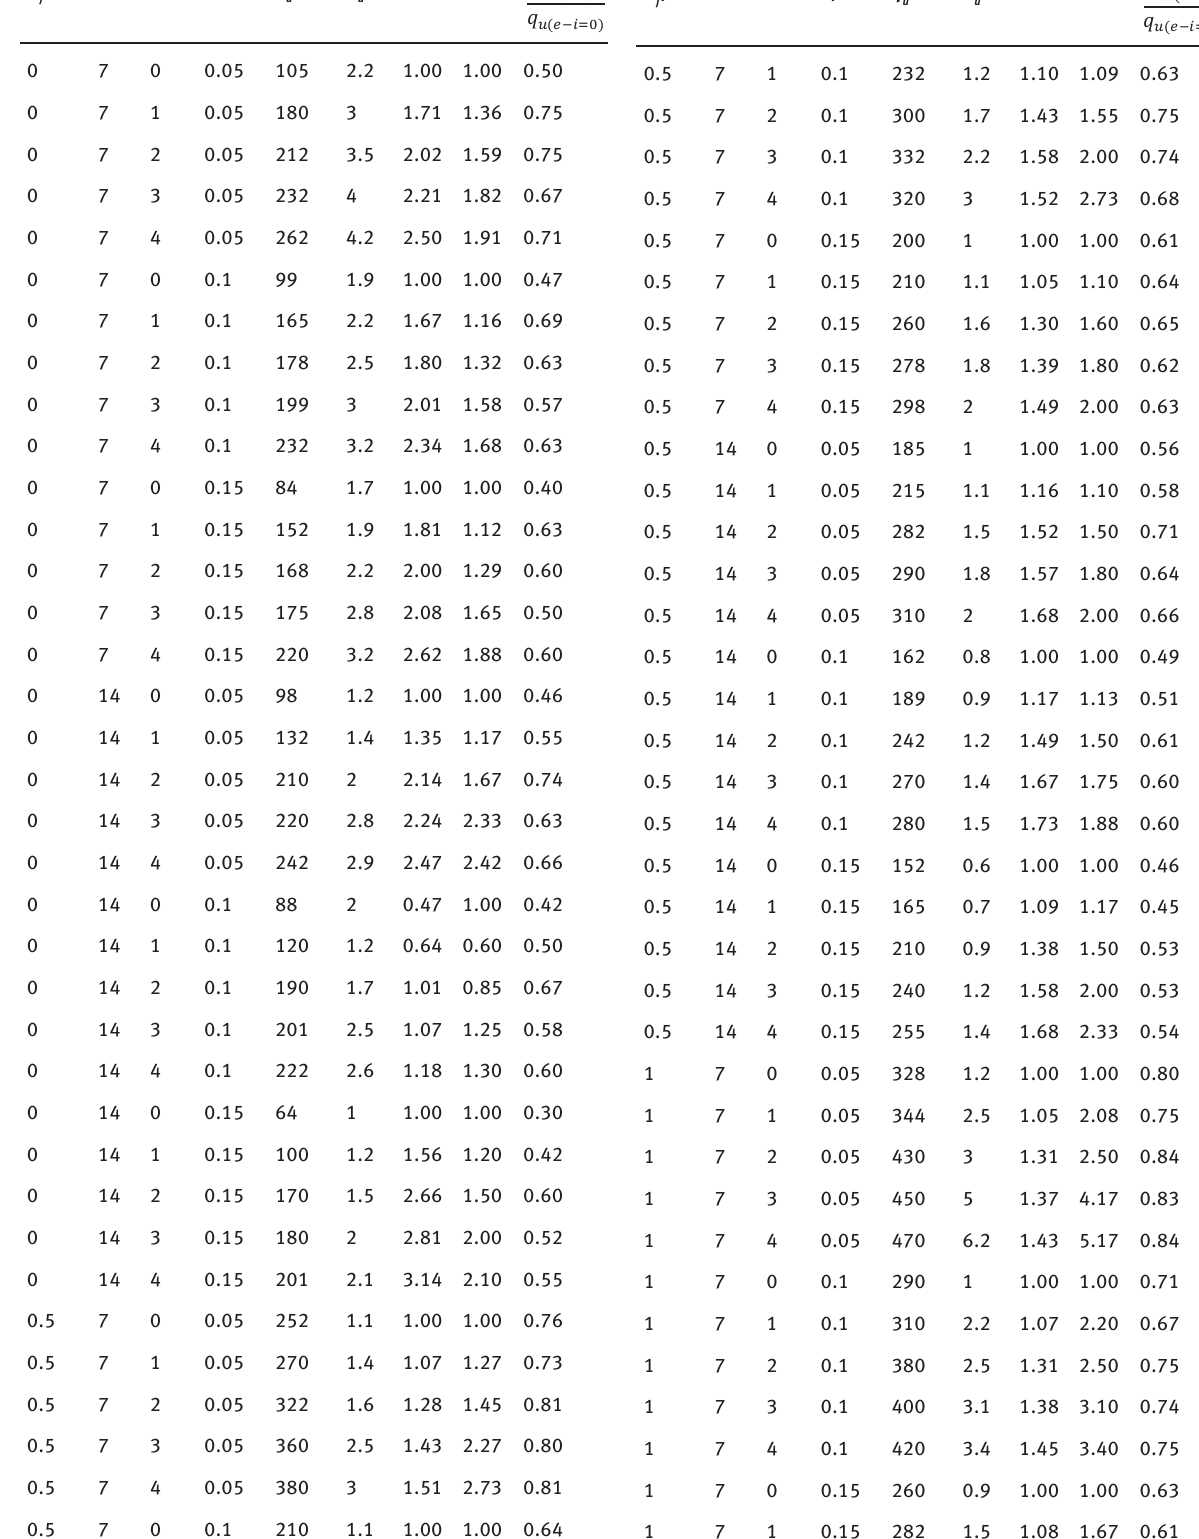
Table 6: Results of eccentrically inclined, loaded ( a ̊, e / B ) rectangular footing in unreinforced and reinforced sand conditions. ⁄ D f